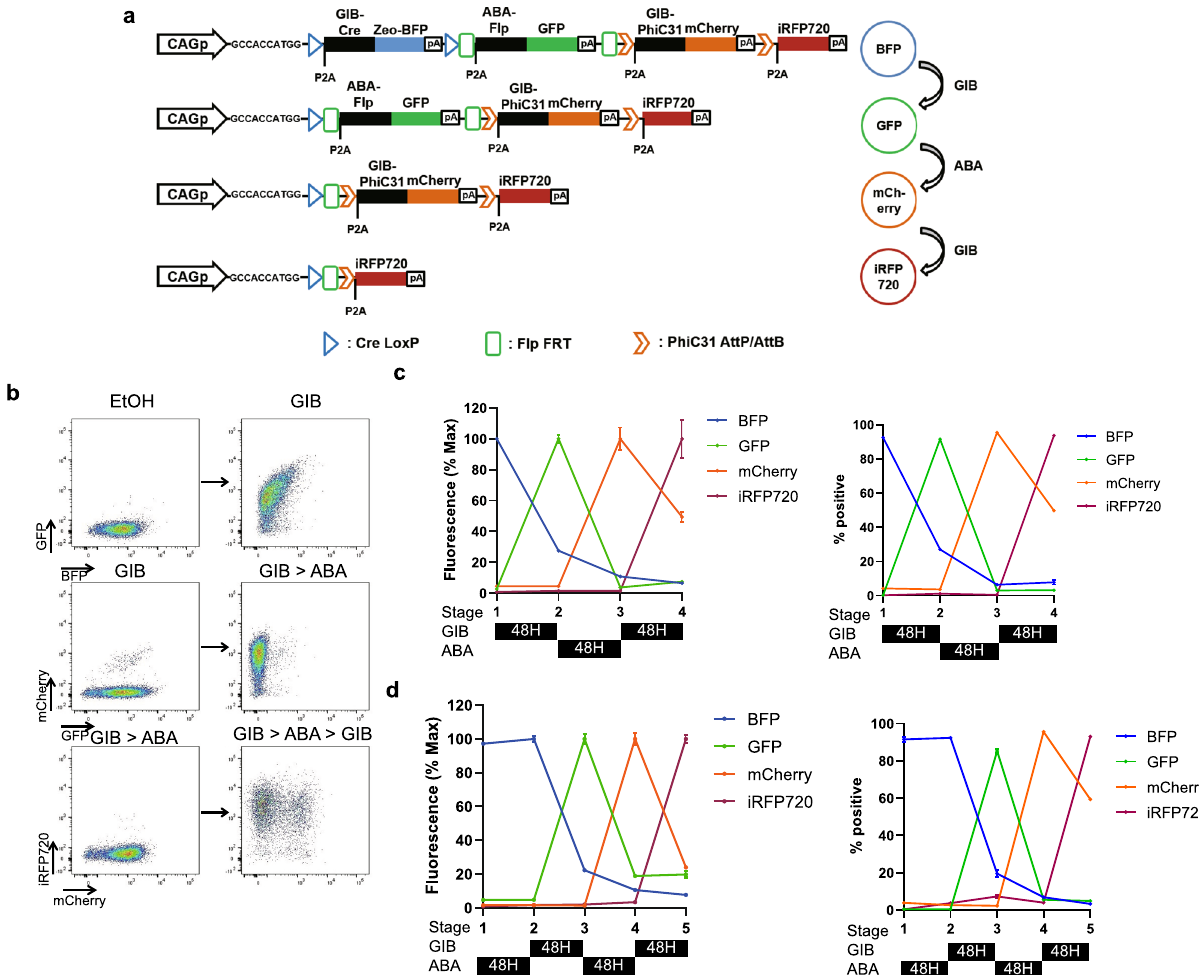
Fig. 2 Design and validation of the tandem GPC gene circuit. a Tandem GPCv2-Fluor gene circuit, used in b – d . Alternating treatments of GIB and ABA result in excision of GPCs and payload gene switching from BFP to GFP, to mCherry, and fi nally to iRFP720. Zeocin resistance gene is placed in the GIB-Cre GPC for positive selection of the gene circuit. CAGp: Hybrid promoter consisting of cytomegalovirus (CMV) early enhancer-chicken beta actin promoter- rabbit beta globin splice acceptor, P2A: porcine teschovirus-1 2A self-cleaving peptides. b Representative fl ow cytometry plot of HEK 293T cells carrying tandem GPCv2-Fluor treated with the indicated sequence of CID ligands. The fl ow cytometry plots for all relevant channels and gating schemes are provided in Supplementary Fig. 3a. c Quanti fi cation of mean fl uorescence and average fraction of cells expressing the indicated fl uorescent protein at each stage of the gene expression cascade ( n = 3, mean ± s.d.). d Quanti fi cation of mean fl uorescence and average fraction of cells expressing the indicated fl uorescent protein after each indicated sequence of ligand treatment ( n = 3, mean ± s.d.). The fl ow cytometry plots for all relevant channels and